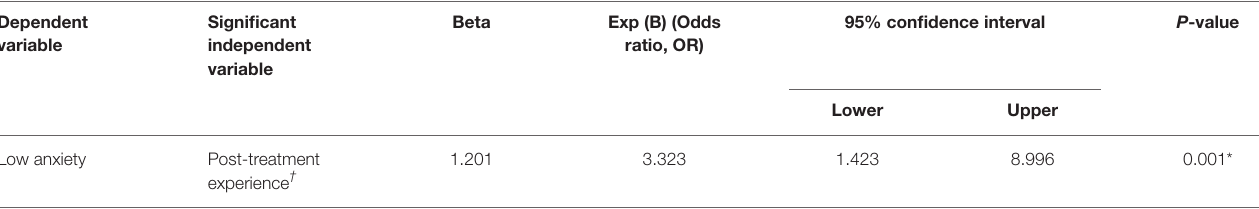
TABLE 5 | Multivariable linear regression: influence of the independent variables (age, sex, previous root canal experience, clinician level of training, number of root canal treatments received, and post-treatment experience) on low